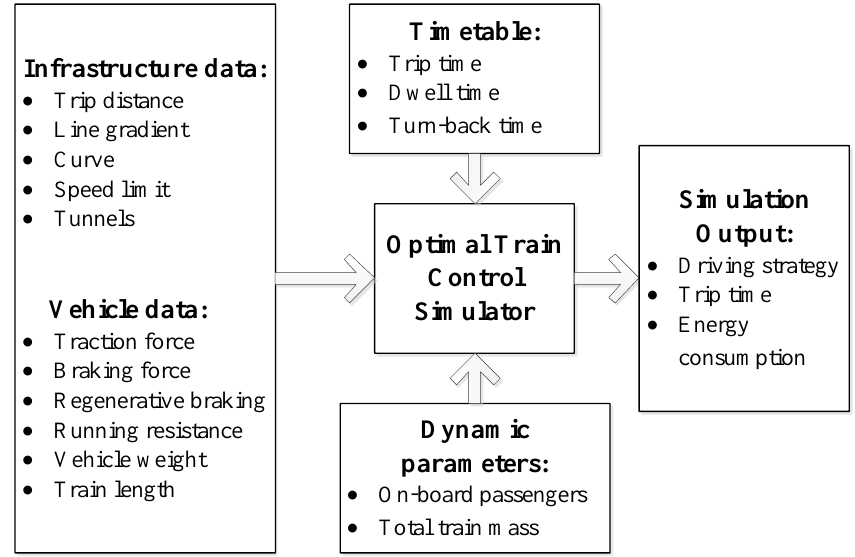
Figure 3. The flow chart of the